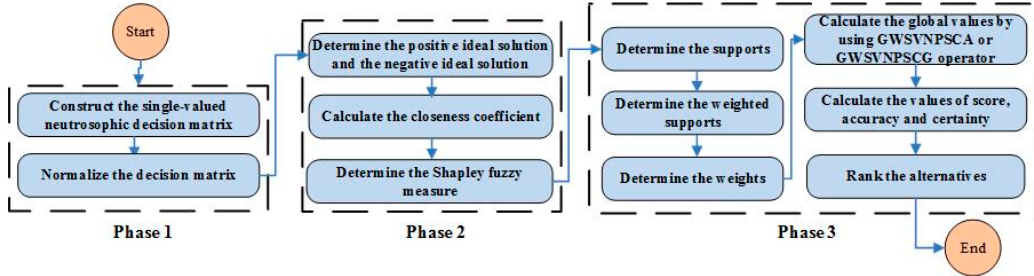
Figure 1. The scheme of proposed method.